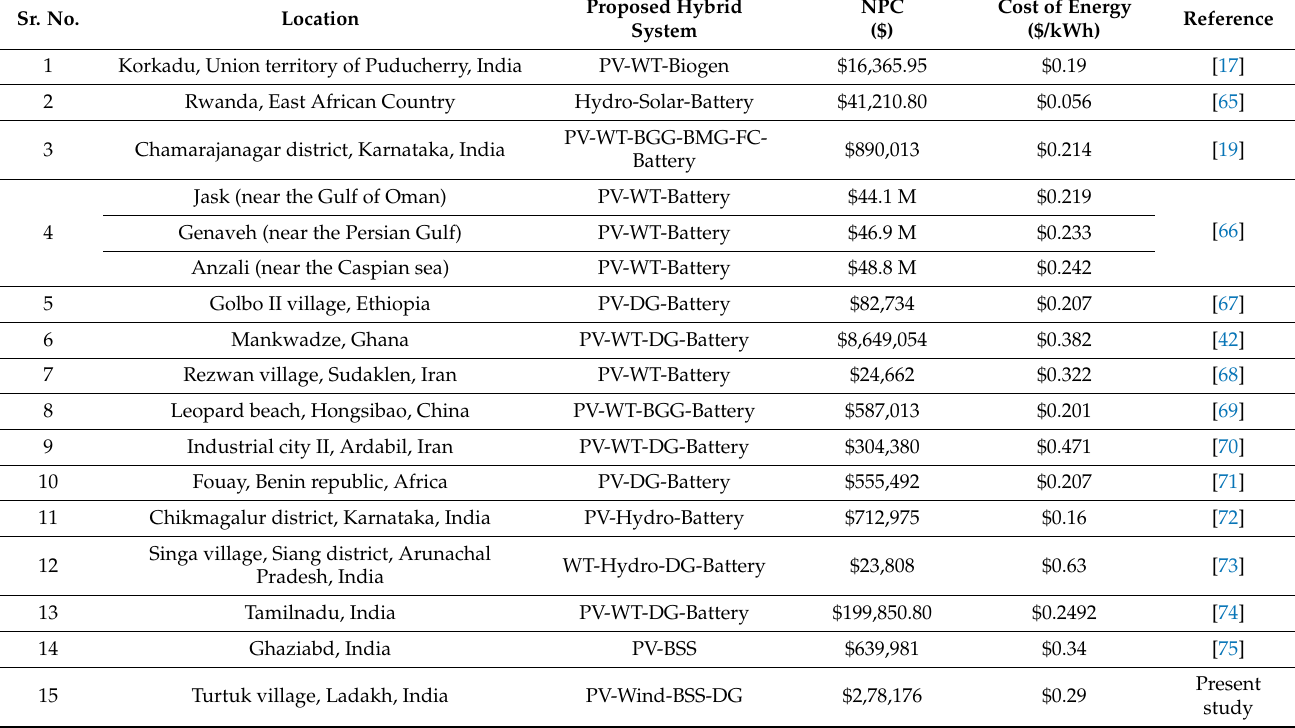
Table 10. Comparison of stand-alone hybrid systems at different